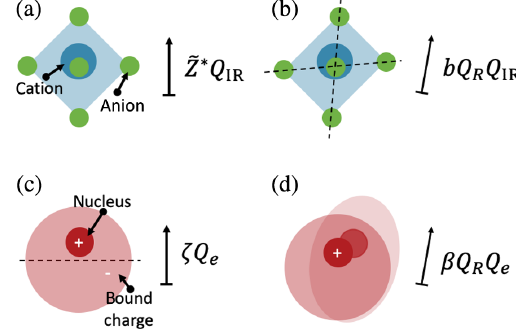
⃗ P FIG. 1. Contributions to Δ in centrosymmetric crystals. (a) In an electric field, relative displacements of cations (blue) and anions (green) contribute to the lattice (ionic) polarizability. The lattice polarizability is responsible for the dominant features of the low-frequency dielectric response in the mid- and far infrared. (b) Displacement of Raman phonons (shown, for example, as a distortion of the octahedral oxygen environment) alters the strength, and possibly direction, of the lattice polarizability. (c) A cloud of electrons bound to a nucleus displaces in response to an electric field. This electronic polarizability is responsible for the high-frequency dielectric response. (d) Displacement of Raman phonons alters the electronic polarizability. This is the conventional Raman effect. A single atom is shown, although collective motion of Raman phonons is necessary for this